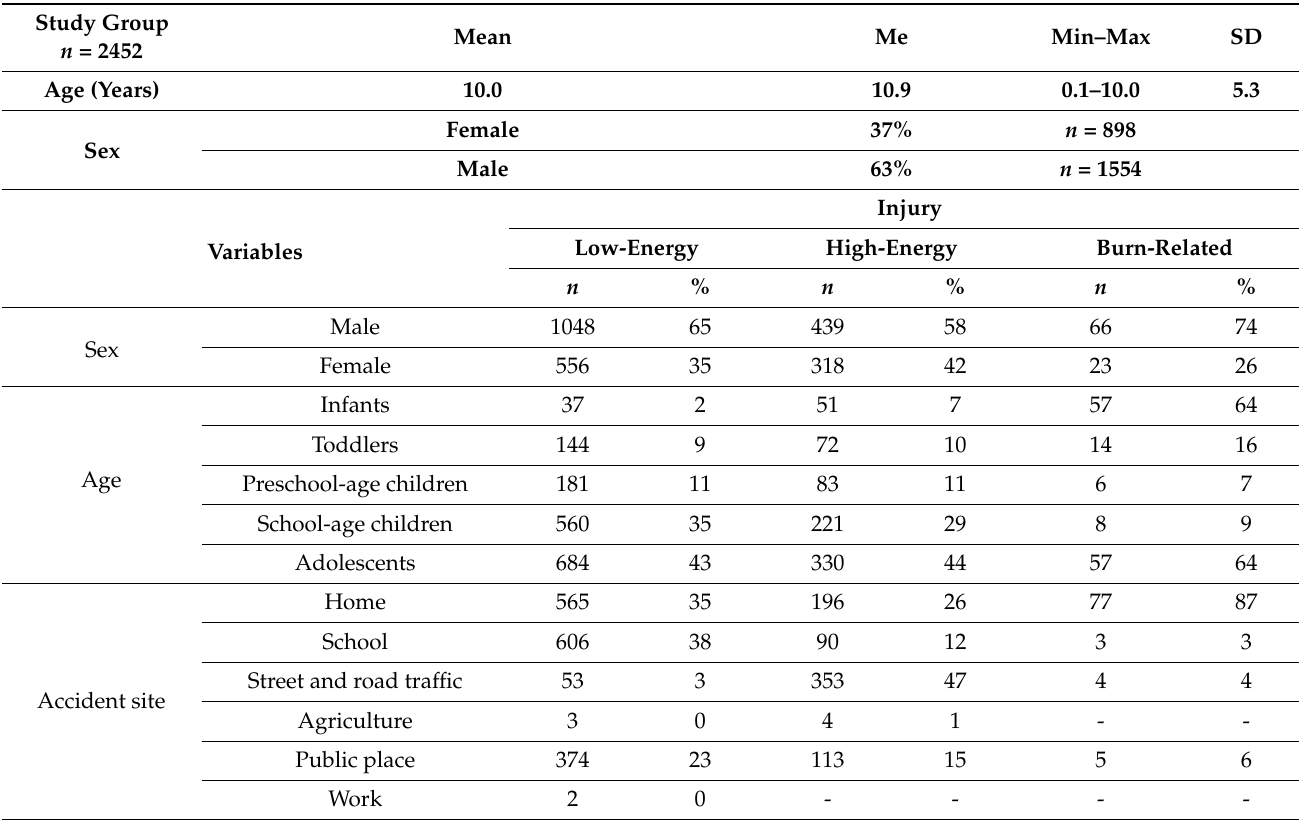
Table 1. Characteristics of the study group and a comparison of the number of patients with a specific injury according to sex, age and accident site.